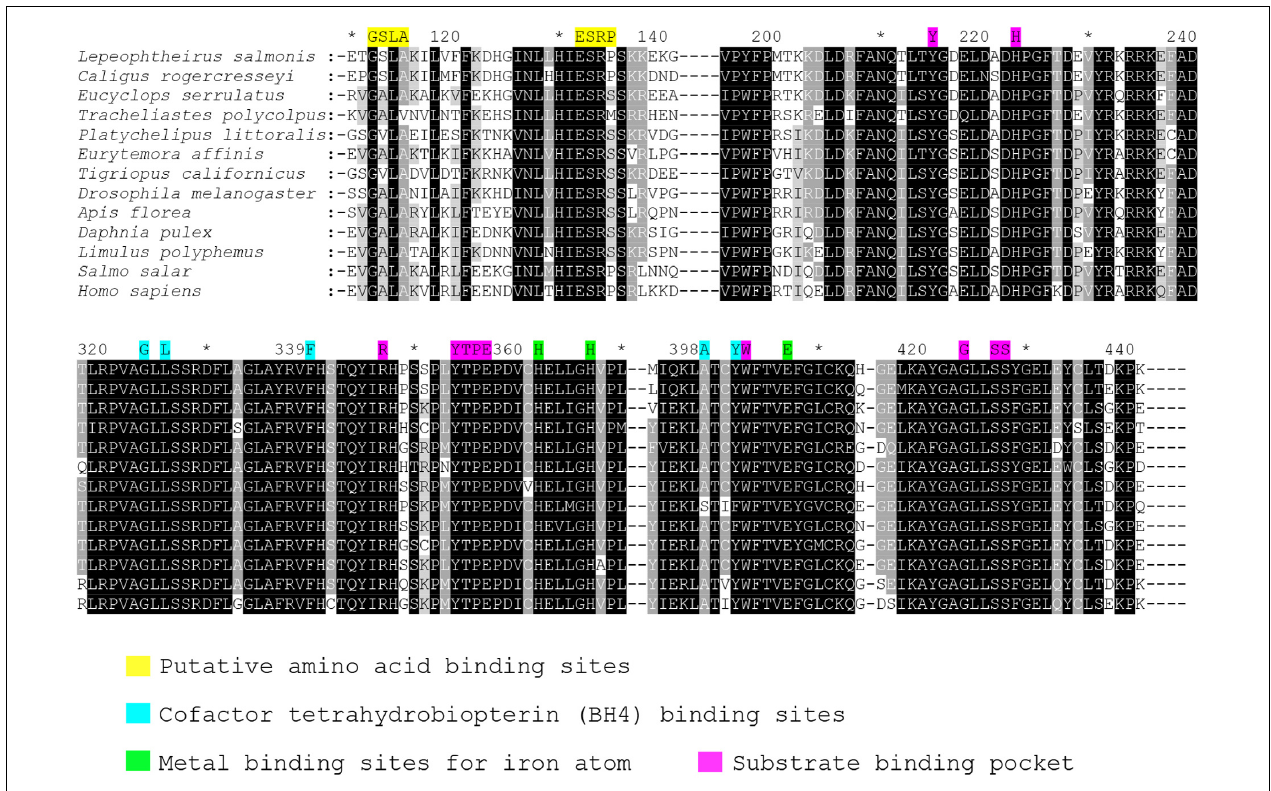
FIGURE 1 | Sequence alignment of PAH proteins. A partial sequence alignment of PAH protein from various organisms. The conserved binding domains are indicated by different colors.